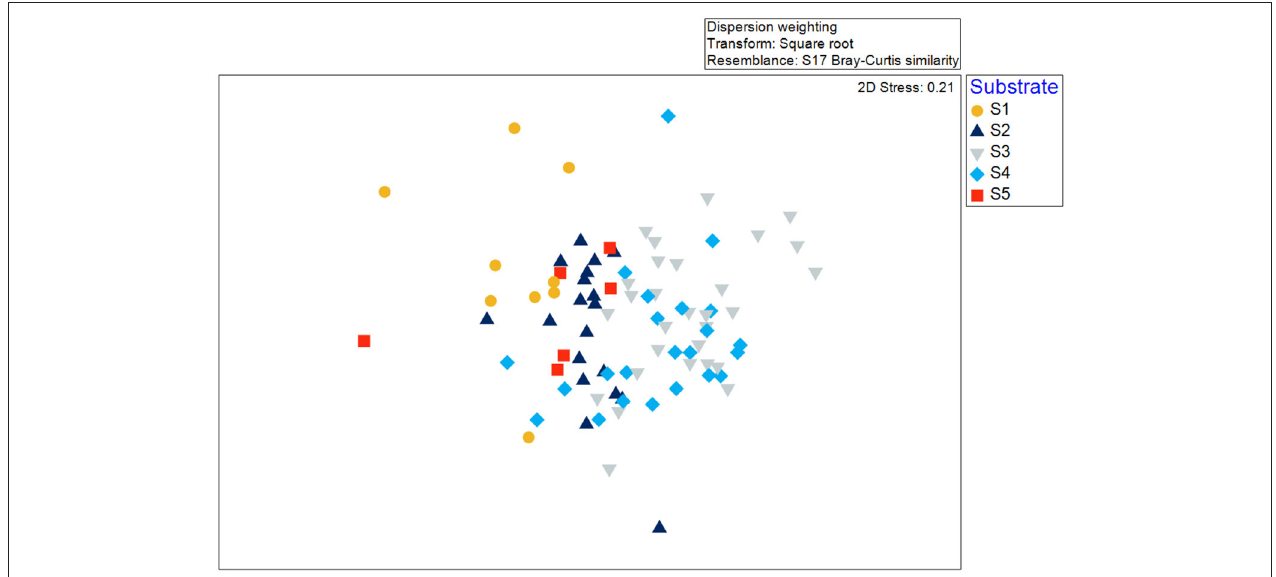
FIGURE 6 | Non-metric multidimensional scaling (nMDS) as a visualization of similarity between video transects collected in the Eastport MPA in 2015. Symbol shape and color indicate the unsupervised substrate